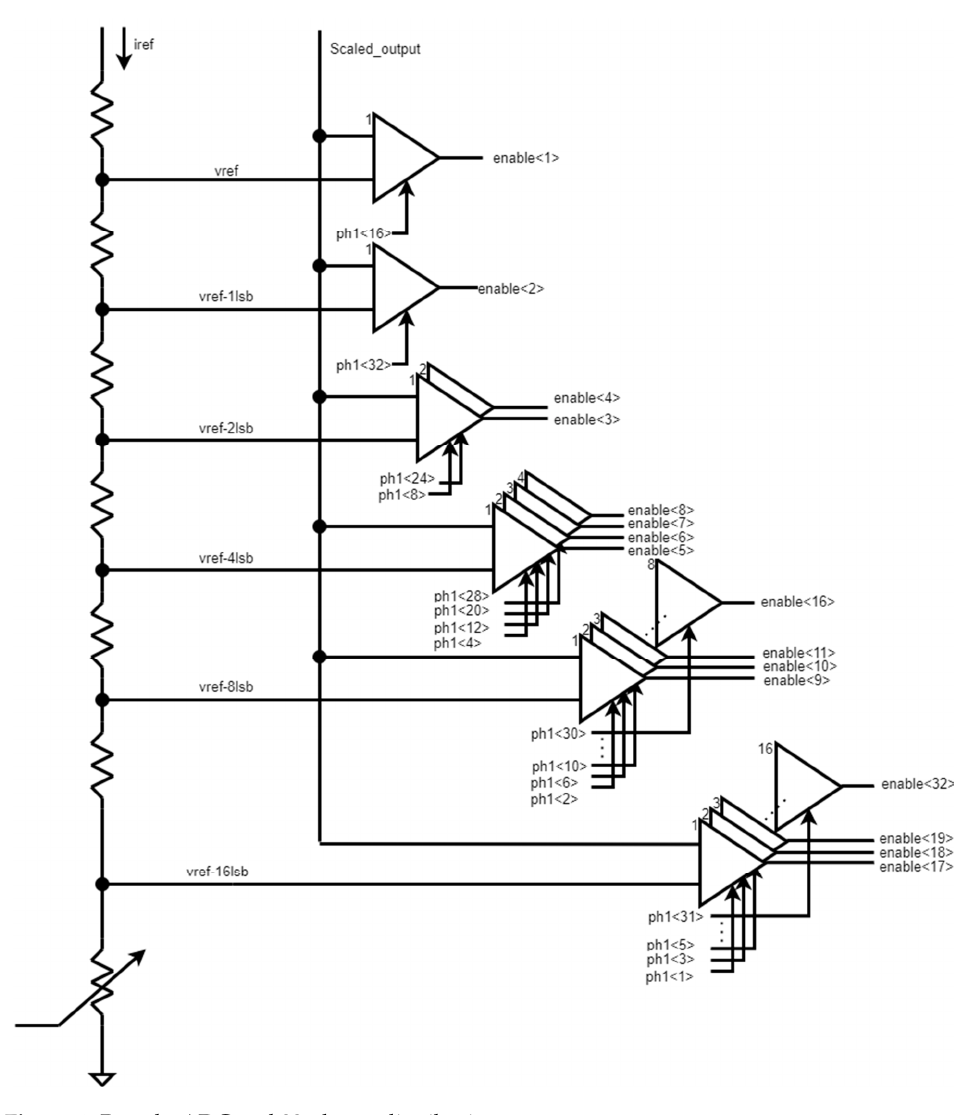
Figure 4. Pseudo-ADC and 32 phases distribution.